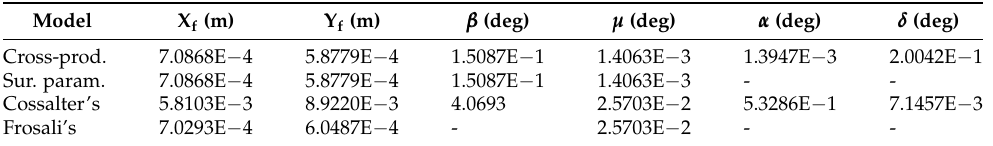
Table 2. Calculation of the RMSE for comparing the kinematic models. The SIMSCAPE MULTIBODY simulation results are set as the reference with a fixed roll angle equal to